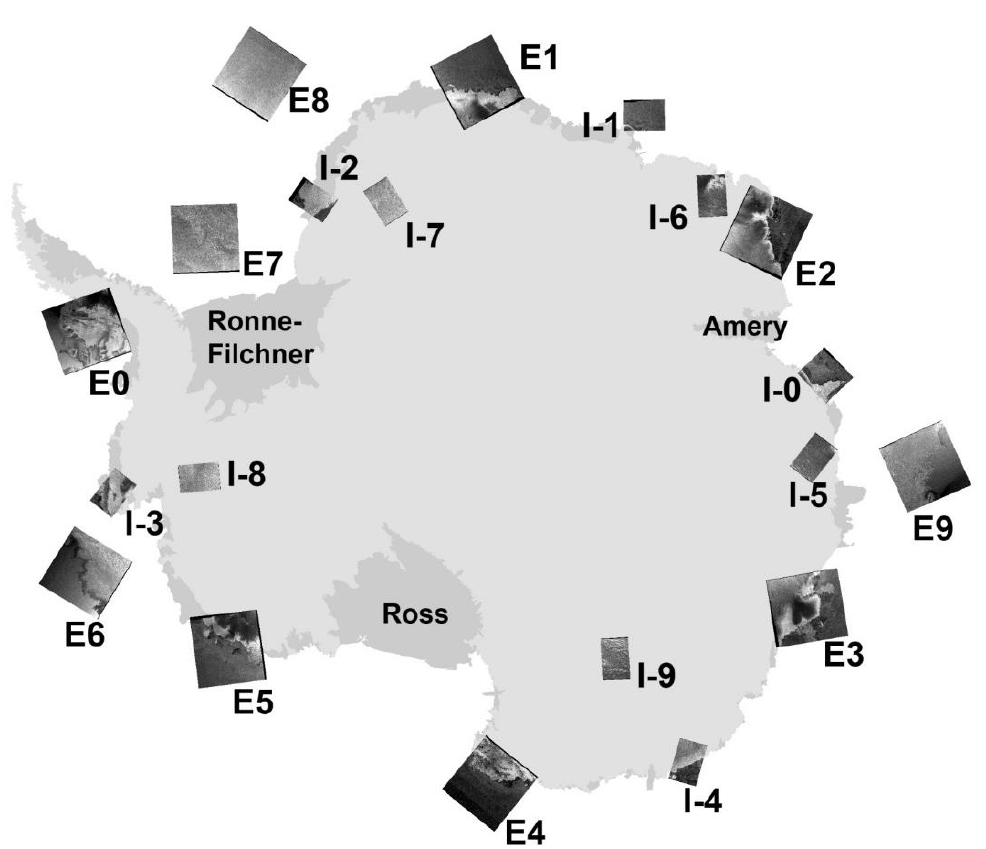
Figure 7. Spatial coverage of the sentinel-1A images over Antarctic inland, coast and ocean. ‘E0’ to ‘E9’ are indices for images from the EW observation model. ‘I-0’ to ‘I-9’ stands for images from IW observation mode. A polar stereographic projection with − 71 ◦ S as standard latitude is